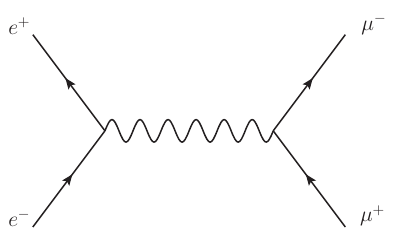
Figure 1: Feynman diagram for electron-positron scattering into a muon-antimuon pair at tree